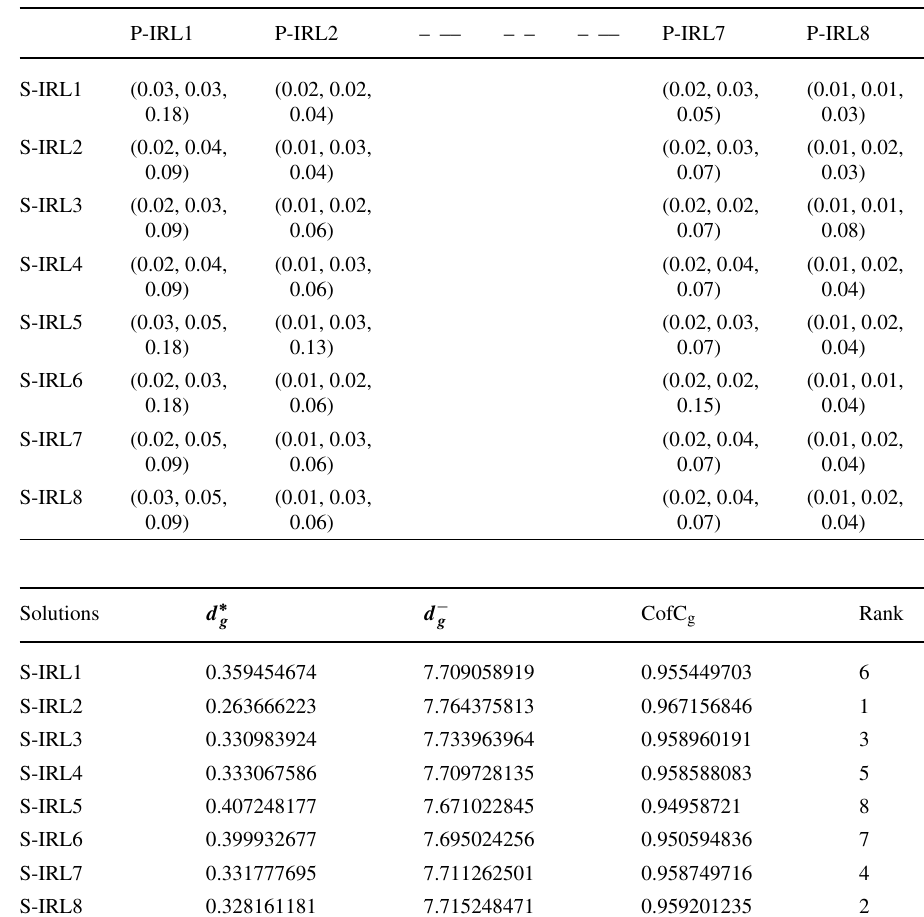
Table 12 Weighted fuzzy evaluation matrix for solutions